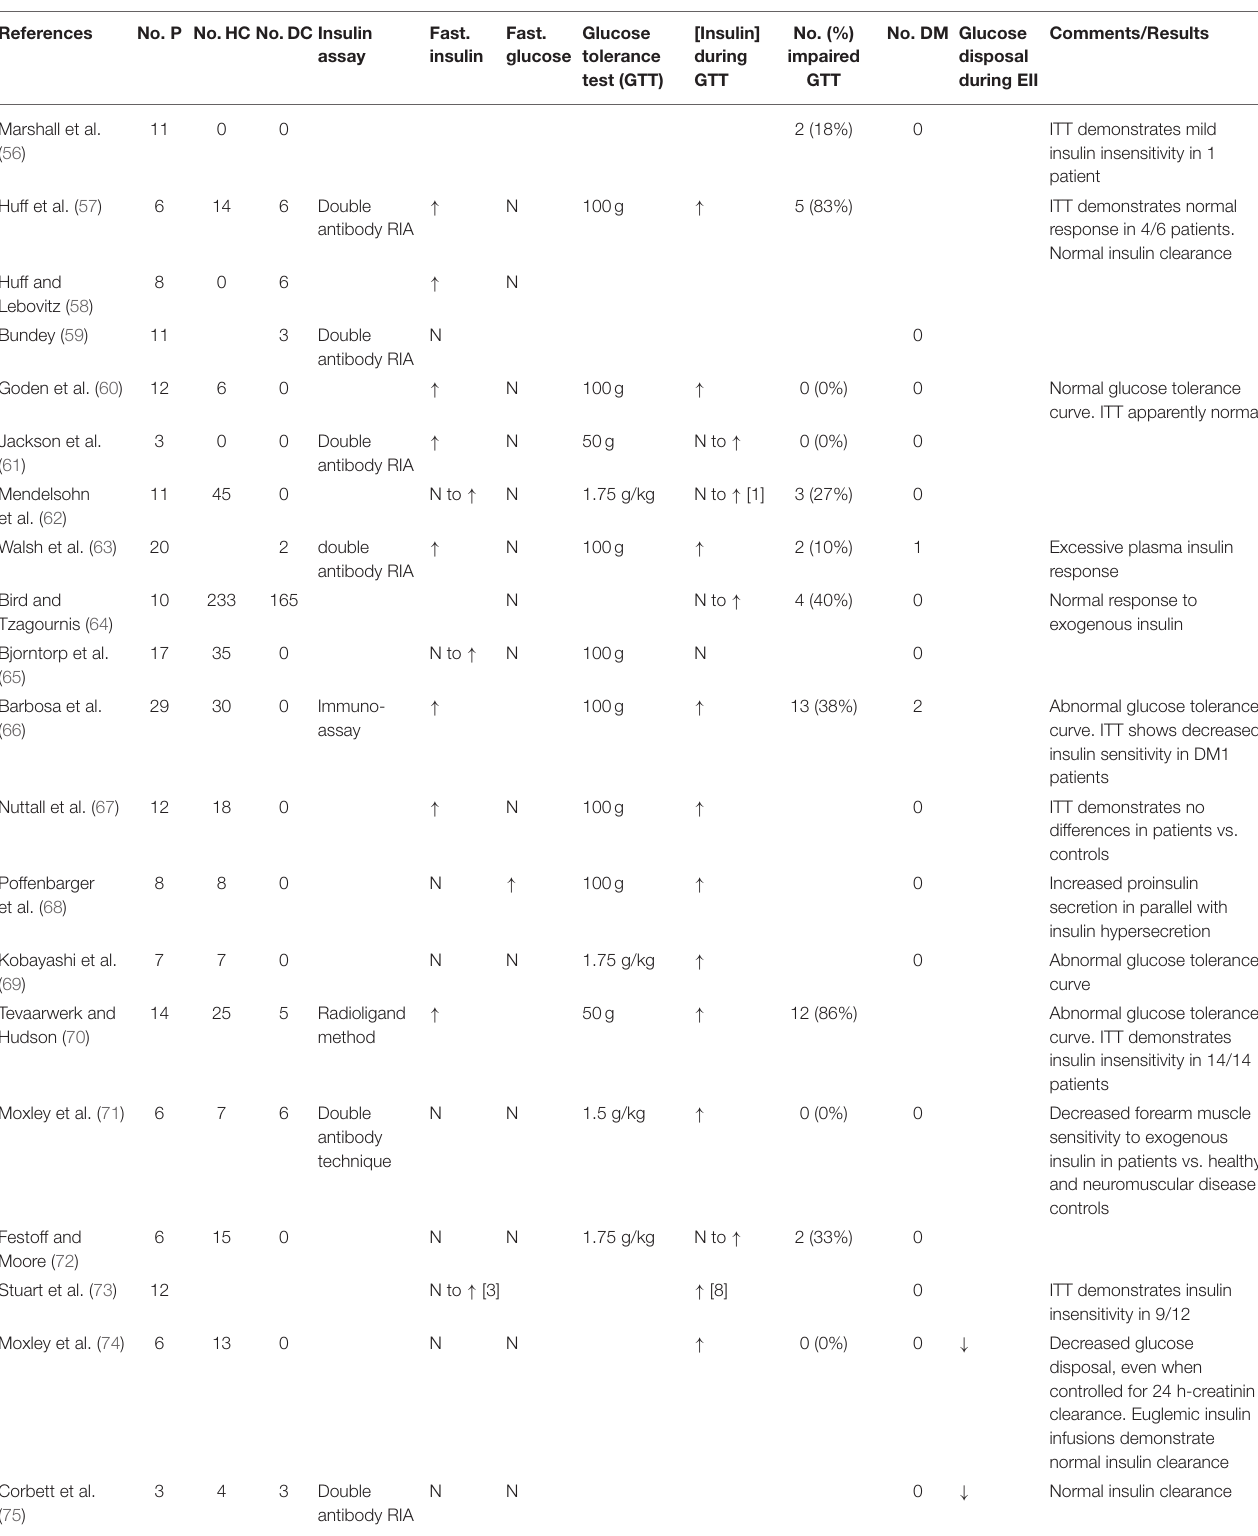
TABLE 1 | Clinical insulin studies in myotonic dystrophy type